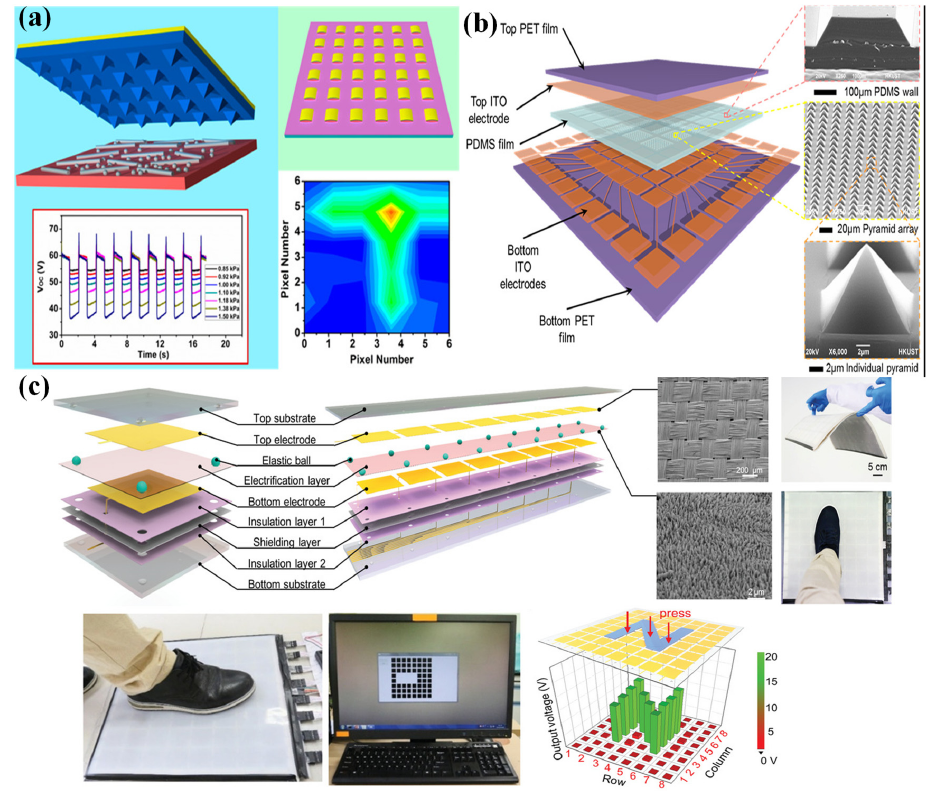
Figure 5. ( a ) A triboelectric sensor array for self-powered static and dynamic pressure detection and tactile imaging. Reproduced with permission from Ref. [88]. Copyright 2013, American Chemical Society. ( b ) An integrated flexible, waterproof, transparent, and self-powered tactile sensing panel. Reproduced with permission from Ref. [93]. Copyright 2016, American Chemical Society. ( c ) A large-area integrated triboelectric sensor array for wireless static and dynamic pressure detection and mapping. Reproduced with permission from Ref. [94]. Copyright 2019, John Wiley and